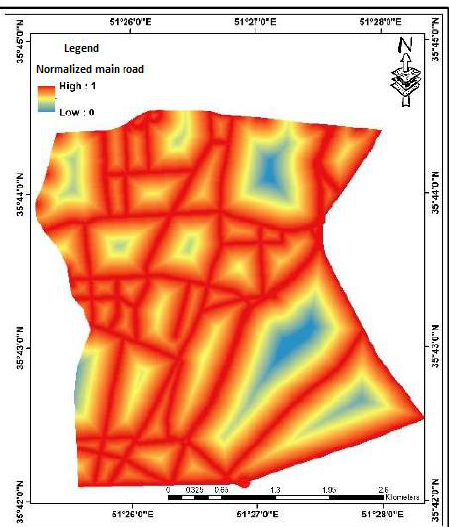
Figure 6. Fuzzy distance from the main roads.